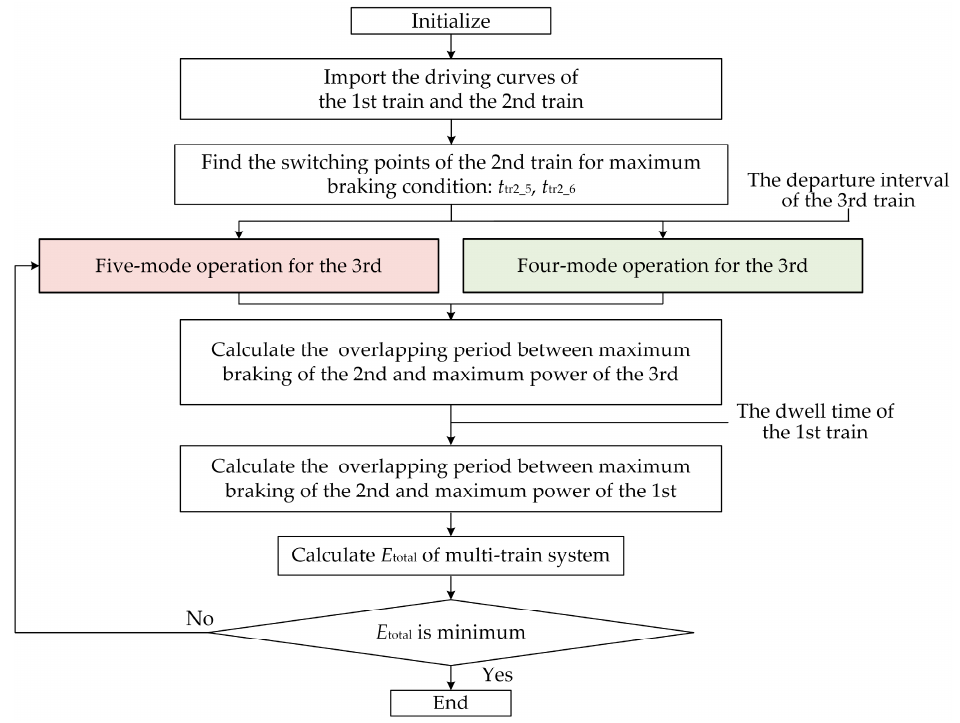
Figure 9. The whole algorithm of the proposed computing method.